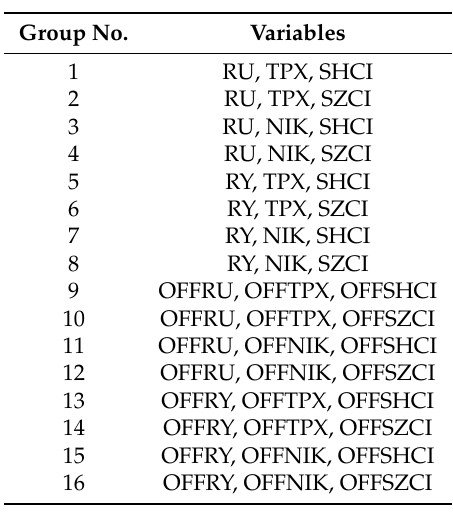
Table 3. Regression Groups